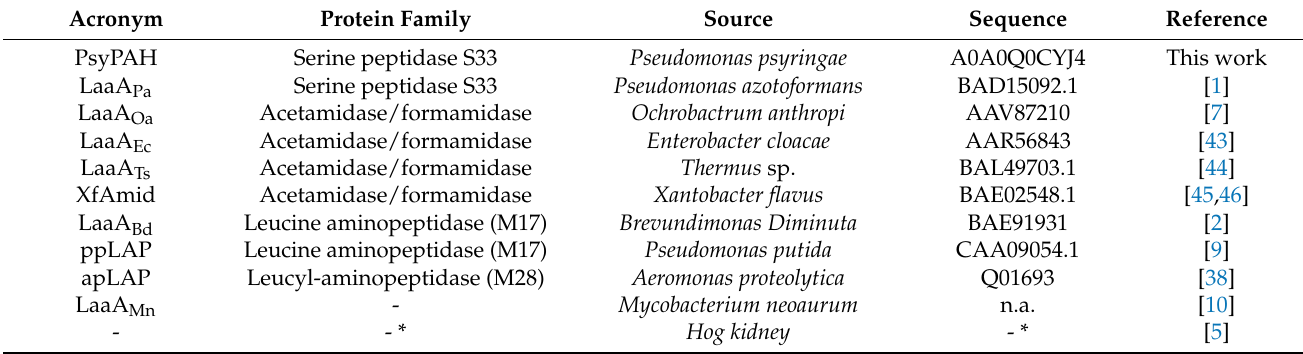
Table 3. Different enzymes with L-enantioselective amidase activity described in the literature with potential application in the production of amino acids. * It is not clear from the literature whether the hog kidney amidase used in the 50s for the resolution of amino acids [5,6] might correspond to a leucyl aminopeptidase or a PAP, or even if they are the same enzyme